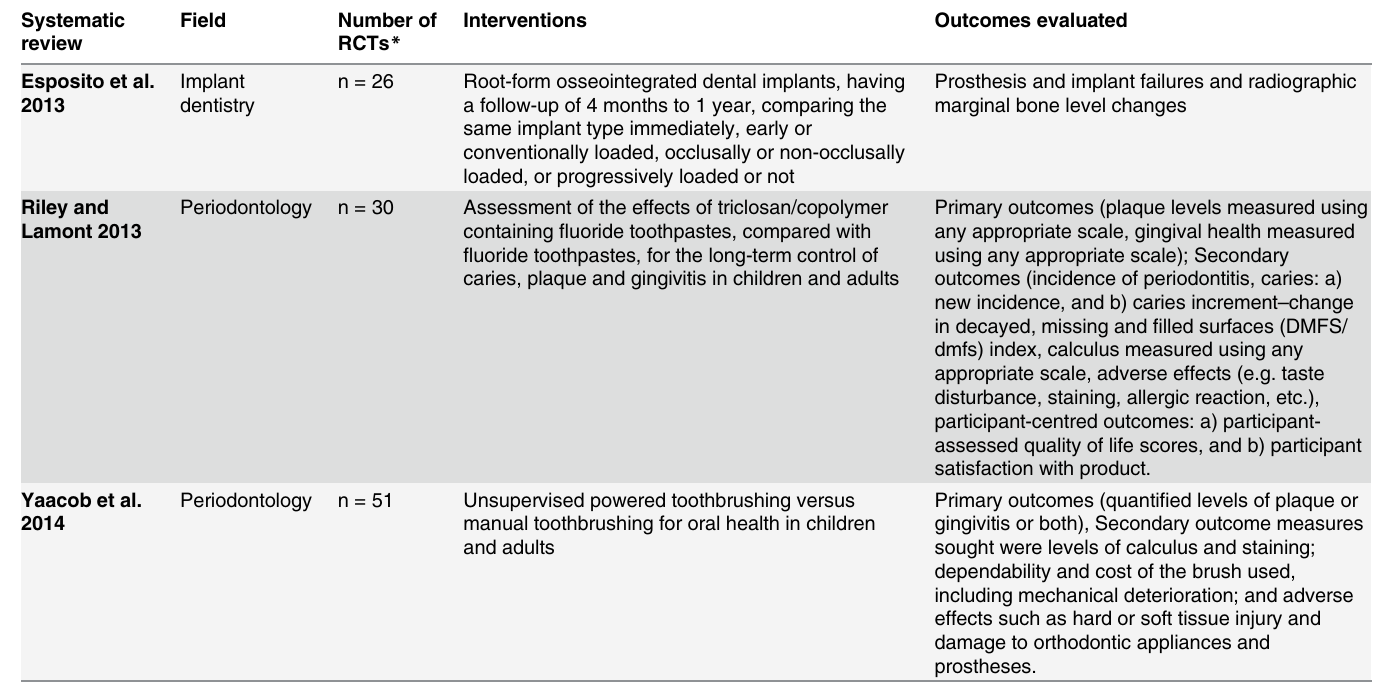
Table 1. Characteristics of included systematic